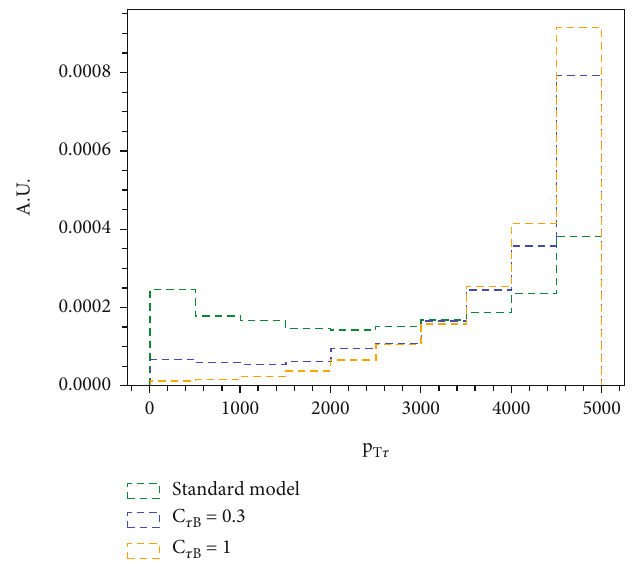
Figure 2: p of τ distributions and the dependence on EFT parameters for μμ ⟶ ττγ productions at a 10 TeV muon collider. T